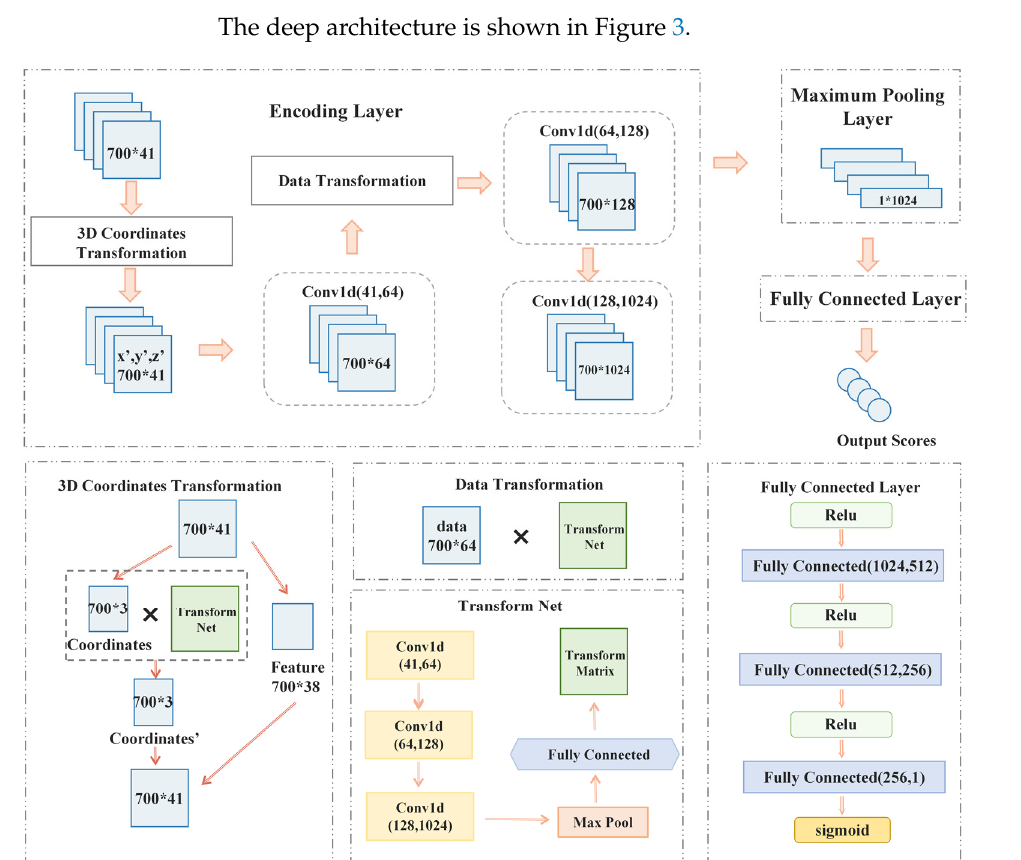
Figure 3. The point cloud-based architecture. Our model contains an encoder, a maximum pooler and a classification head. First, the encoder part takes 700 points as input and applies 3D coordinates and feature transformation. Then, the maximum pooler aggregates point features and transfers them into some fully connected layer. Finally, a sigmoid function gives the probability of the decoy being a near-native decoy.